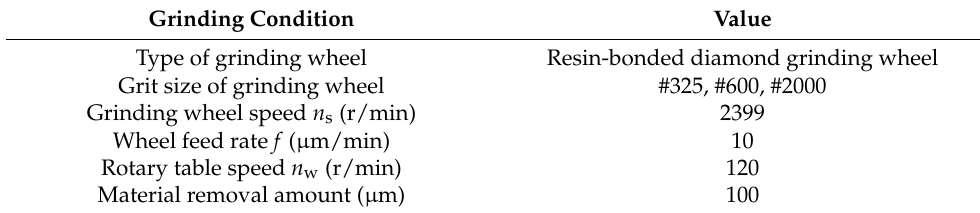
Table 3. Grinding experiment parameters for fiber-reinforced PEEK.